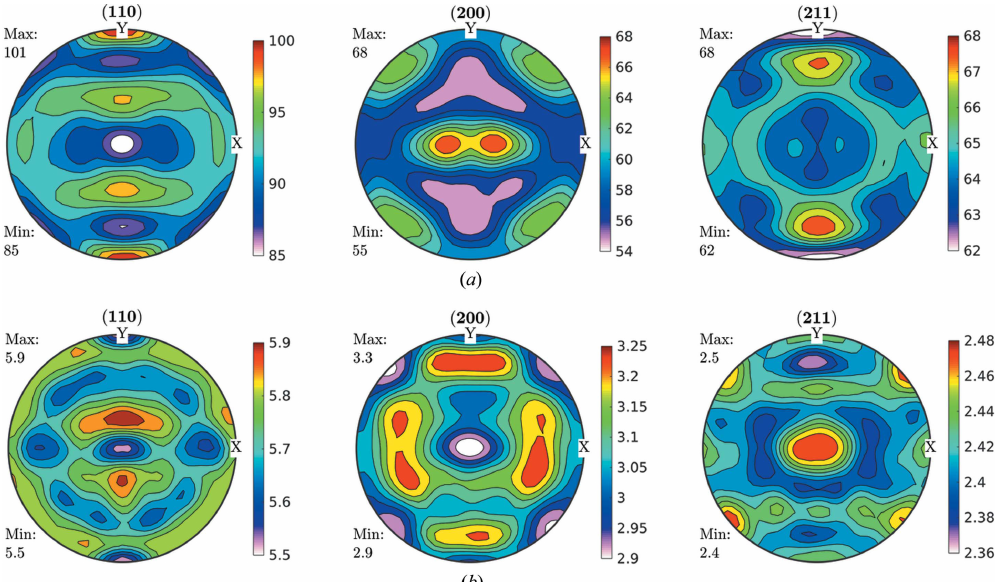
Figure 10 Recalculated GPFs for ( a ) domain size (nm) and ( b ) dislocation density (10 14 m (cid:3) 2 ) as separated by following the Langford model from FWHM GPFs. Heat-treated sample, 5 s at 400 (cid:6)